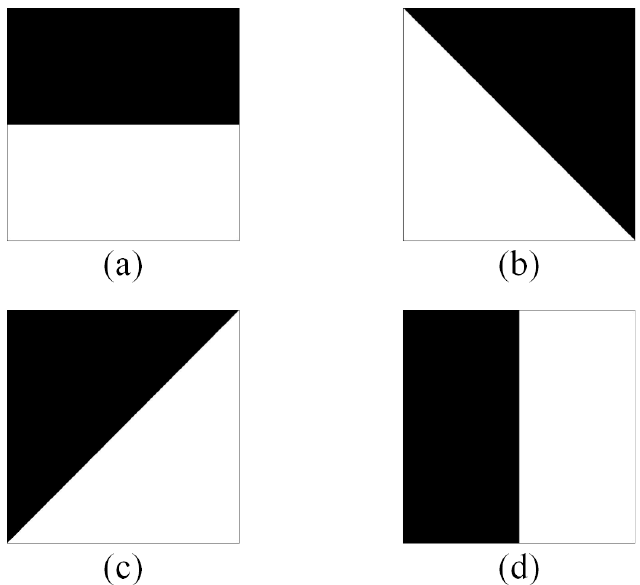
Figure 7. Typical edge direction diagram: ( a ) vertical edge direction; ( b ) 45° edge direction; ( c ) − 45° edge direction; ( d ) horizontal edge direction.